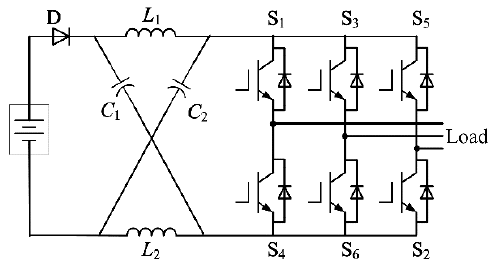
Figure 1. Z-Source Figure 1. Z-Source inverter.